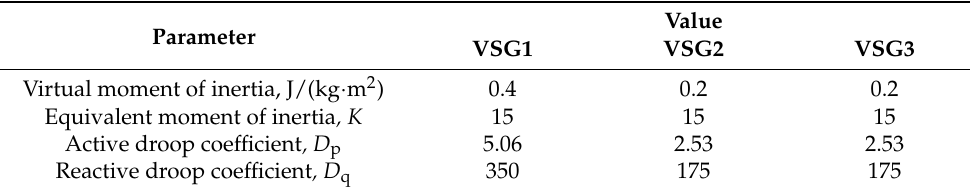
Table 2. Simulation control system